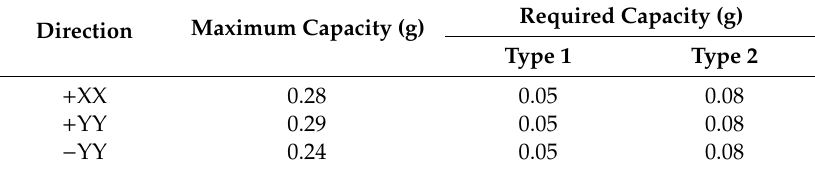
Table 2. Safety verification for seismic action by means of nonlinear static